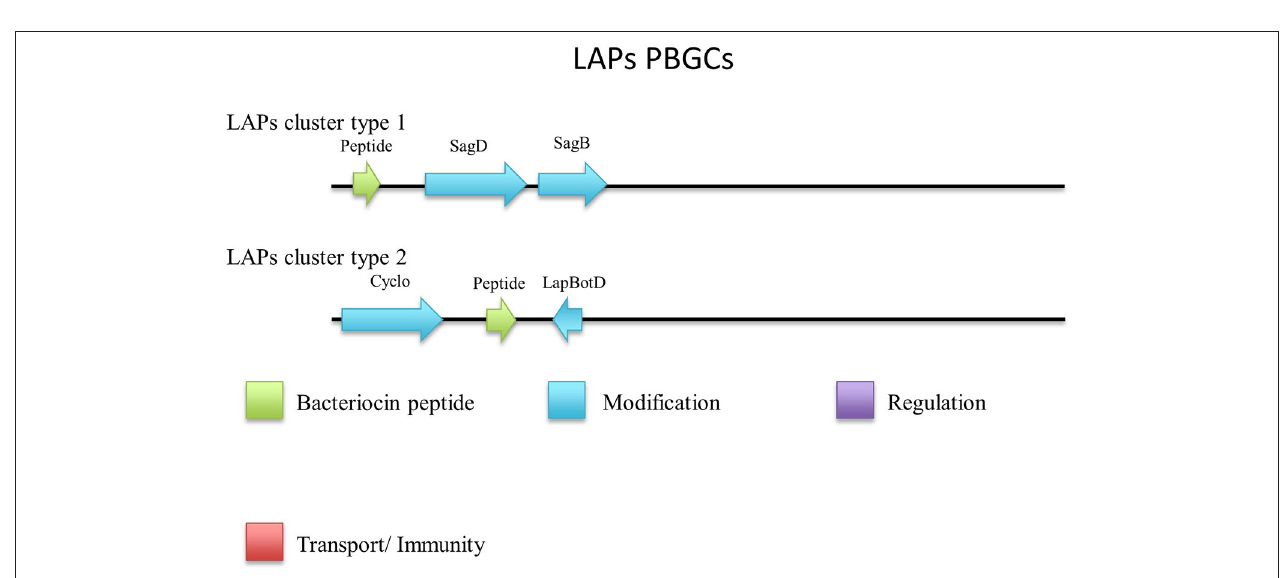
FIGURE 7 | Linear Azole containing peptides (LAPs) cluster types predicted by